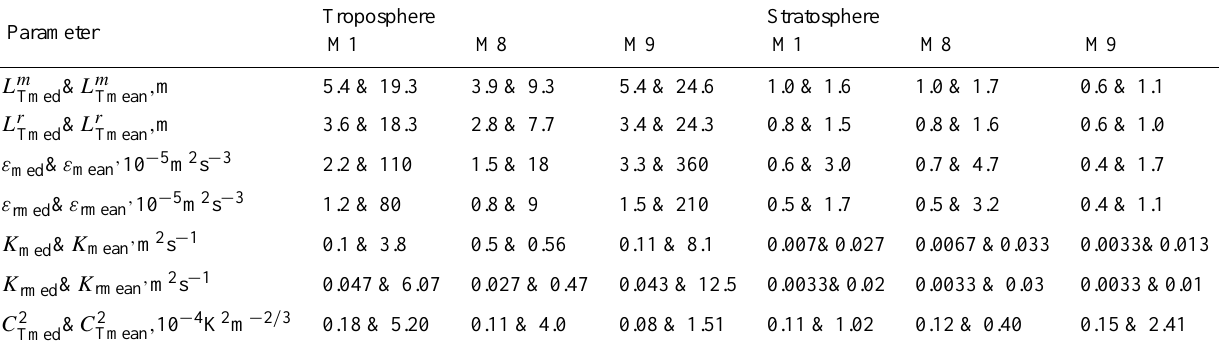
Table 2. Median and average turbulence parameters for flights M1, M8 and M9. Troposphere Stratosphere Parameter